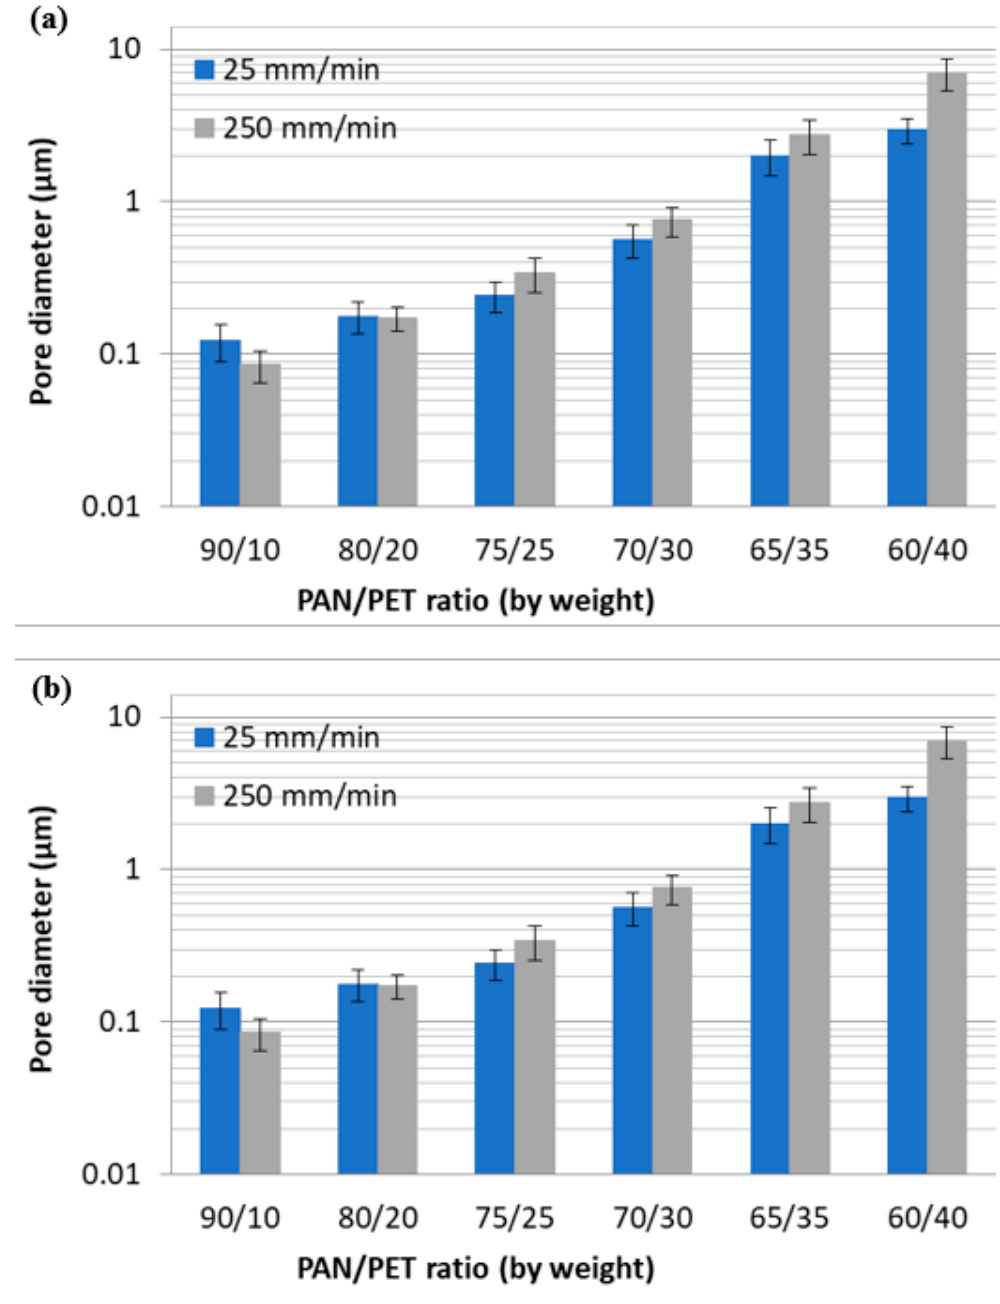
Figure 2. Pore diameters for porous polymer ( a ) and carbon ( b ) films obtained from AFM images. The thicknesses of polymer films obtained were measured using AFM (Figure 3). For the films fabricated using the speed of 250 mm/min, all the polymer films had thicknesses higher than the vertical limit of our AFM (6.42 µ m), and, thus, the thicknesses were not determined. Therefore, the data is reported for the films obtained using the lower withdrawal speed. The pure PAN film had a thickness of 2.73 µ m. The PAN/PET films produced in this study had significantly lower thicknesses than that of the PAN film. The blended films’ thicknesses with 10, 20, 25, 30, 35, and 40 wt.% of PET were 1.72, 1, 1.25, 1.03, 1.43, and 1.28 µ m, respectively. The decrease of the thickness is associated with the decrease of the solution viscosity as part of PAN is replaced with PET. Indeed, according to the classical Landau–Levich theory, the thickness of a film (h) produced by